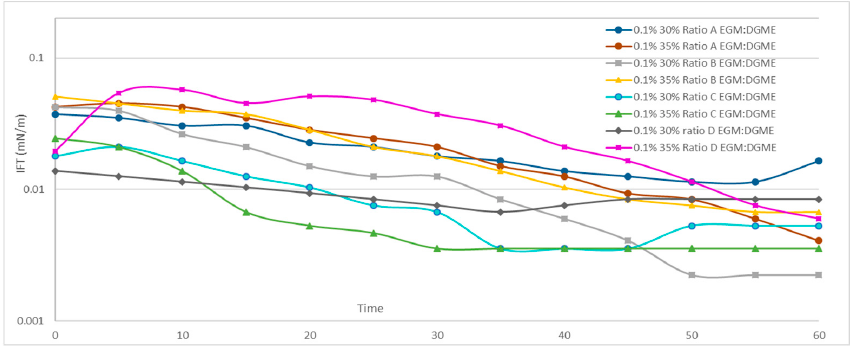
Figure 7. Dynamic IFT for as-synthesized surfactant in the presence of EGME/DGME at different ratio.